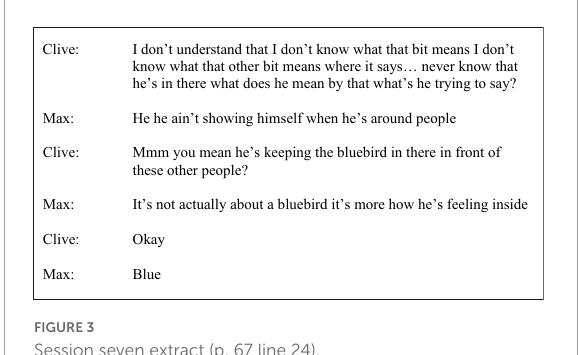
FIGURE3 Session seven extract (p. 67 line 24).